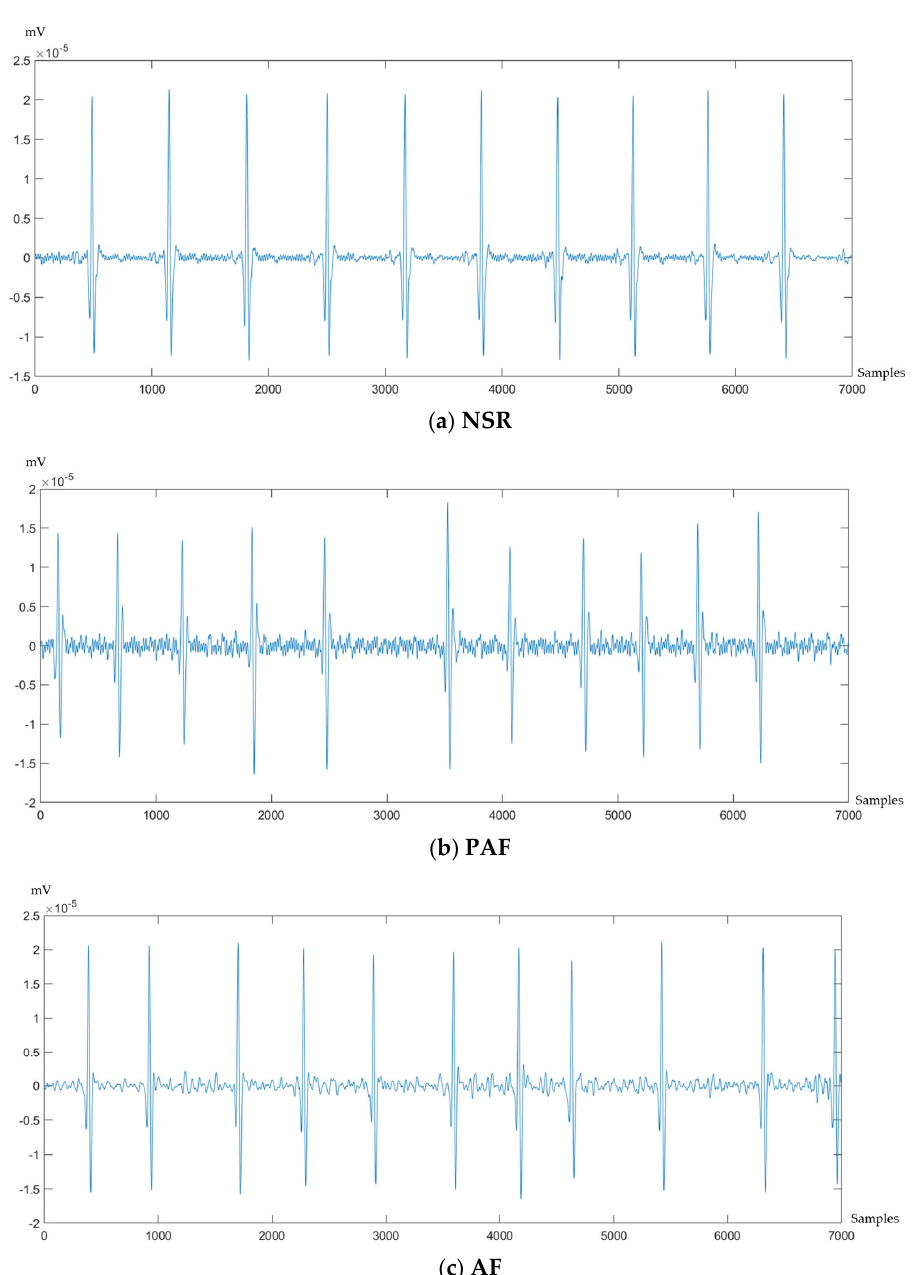
Figure 1. Examples of ECG segments for three types of signals. Most conventional ECG devices in hospitals that detect AF symptoms using RR in ‐ terval signals have limitations in accuracy. The typical waveform comprises the P wave, QRS complex, and T wave. However, when irregular RR intervals occur, the absence of distinct repeating P waves, fluctuating P waves (f ‐ waves), irregular heart rate, and incon ‐ sistent heart rate variability (HRV) are the signs of AF [4,5]. ECG signals of AF patients are not consistent and are nonlinear, so they create difficulty in the judgment of AF pa ‐ tients. Investigations of the relationship between the number of reentrant waves in the atrial chambers and abnormal AF signals from ECG signal patterns using signal pro ‐